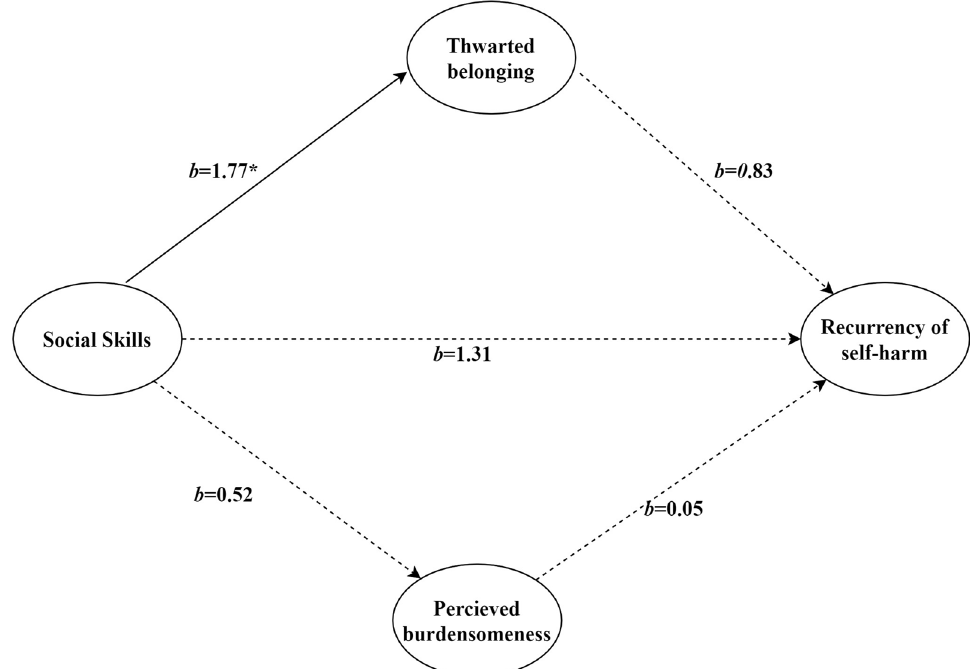
Fig. 2 The connection between social skill and the recurrence of self-harm mediated by IPTS variables